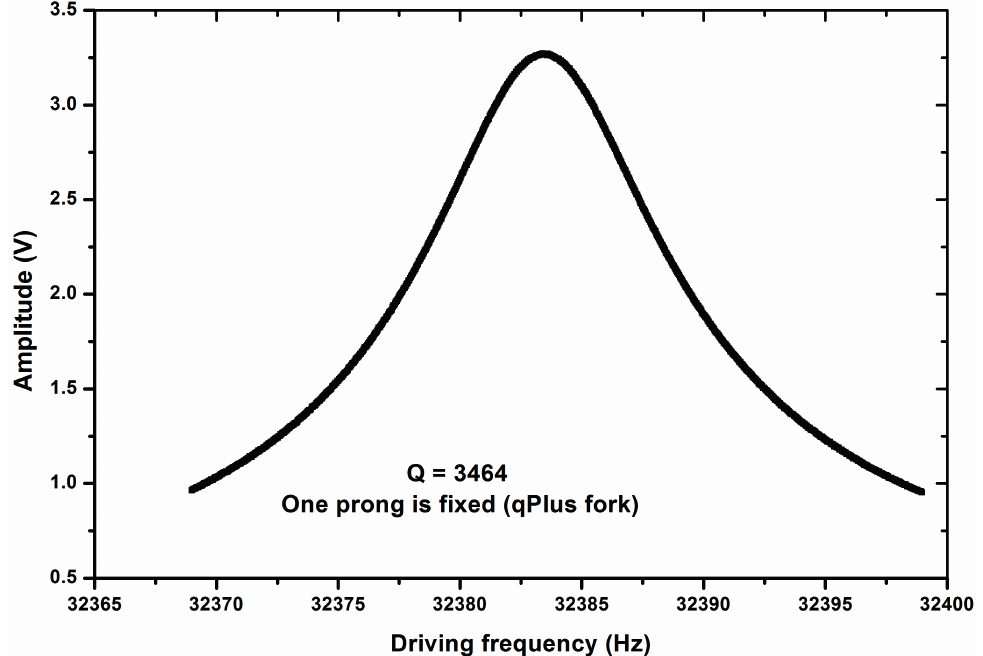
Figure 4. The resonance curve of the qPlus QTF used in the experiment. It is fairly symmetric with a Q factor equal to